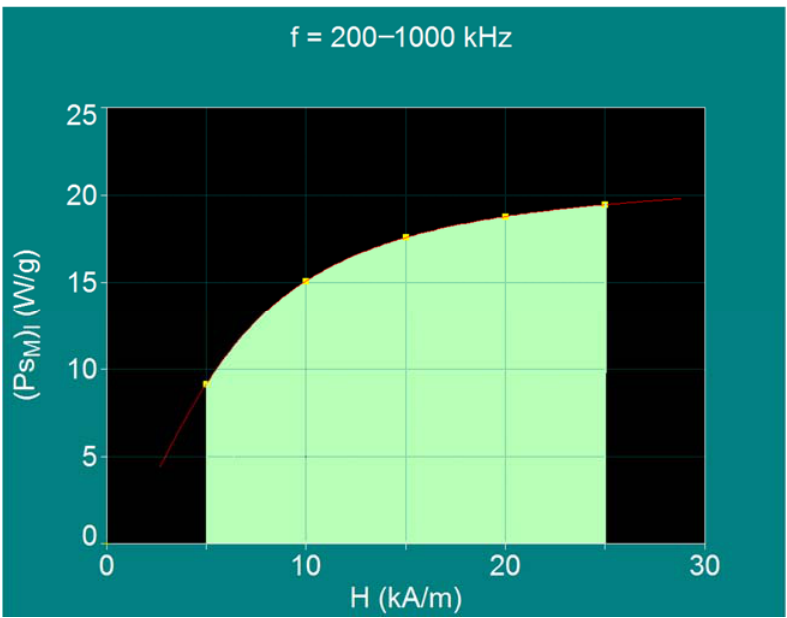
Figure 11. The variation of maximum specific loss power for the allowable biological limit as a function of magnetic field amplitude for Fe 3 O 4 nanoparticles coated with γ -CDs dispersed in liquid.